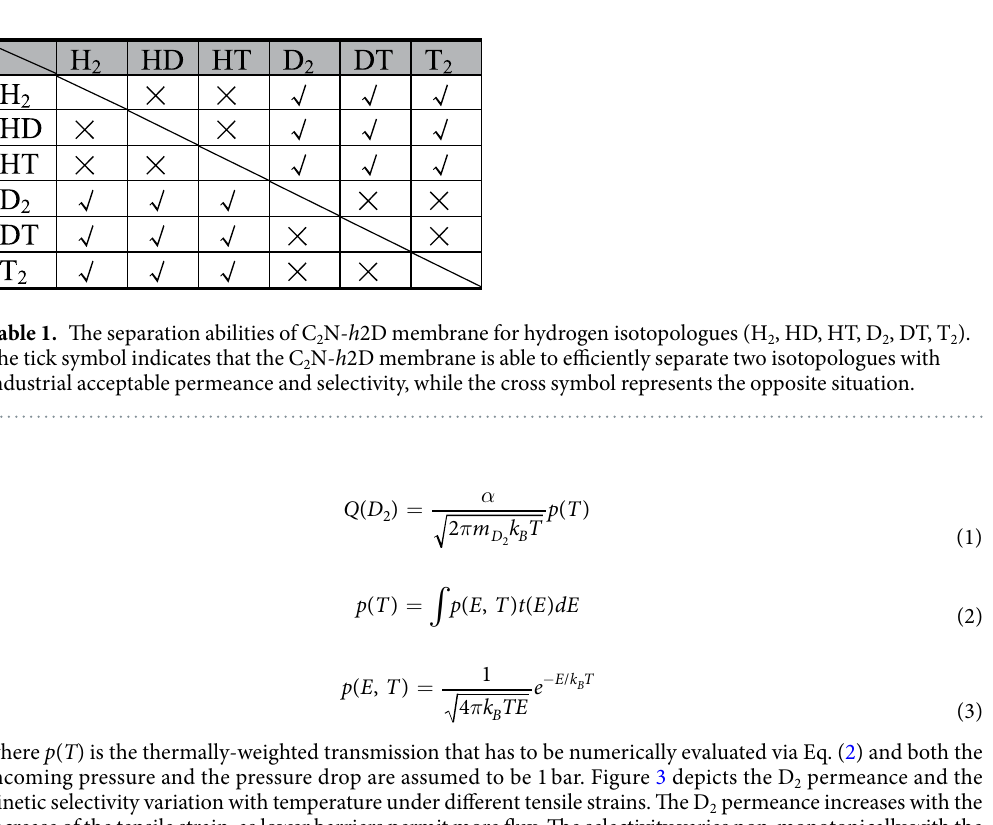
Figure 2. Quantum tunneling probability t ( E ) of hydrogen passing through the pore of C 2 N- h 2D membrane as a function of kinetic energy under different strains. The solid curves represent the quantum-mechanical transmission of H 2 and the dashed curves represents that of D 2 , respectively.